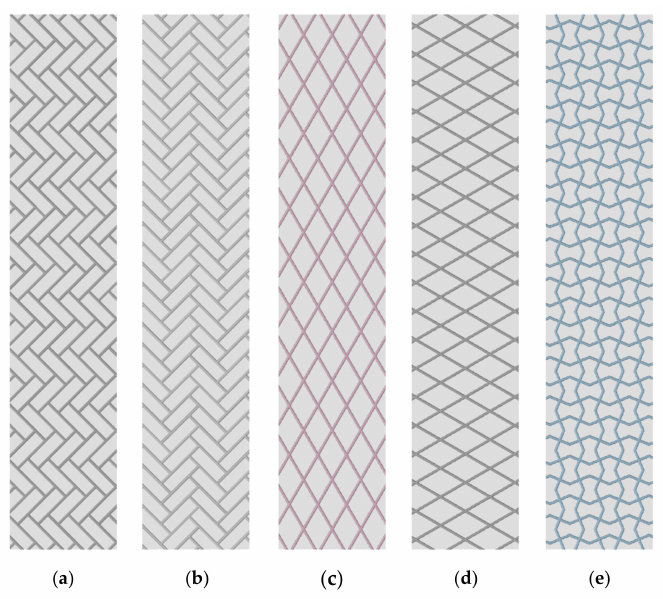
Figure 4. Pattern-embedded specimens: ( a ) Pattern A aligned with the major axis; ( b ) Pattern A aligned with the minor axis; ( c ) Pattern B aligned with the major axis; ( d ) Pattern B aligned with the minor axis; and ( e ) Pattern C.